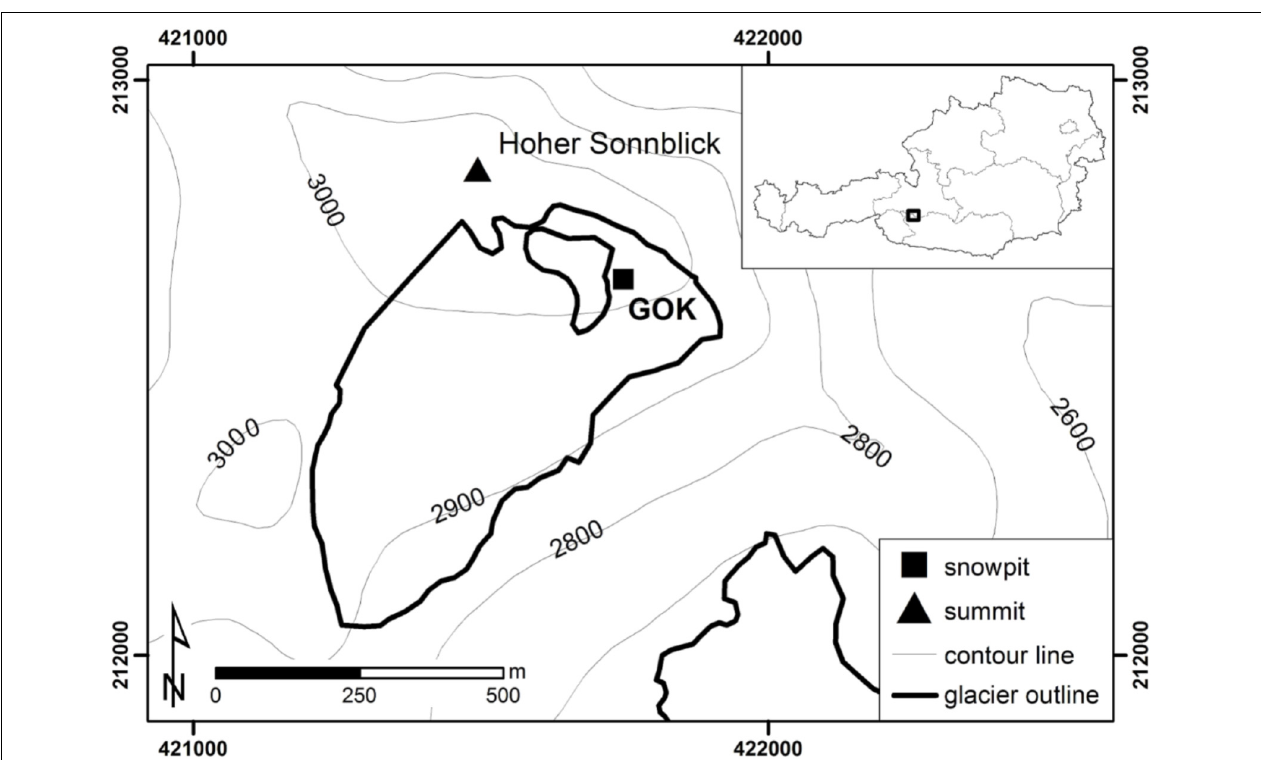
FIGURE 1 | Location of the Goldberggruppe in Austria, the sampling site Goldbergkees (GOK) on a glacier field in the Eastern Alps and of the mountain summit Hoher Sonnblick where the meteorological observatory is